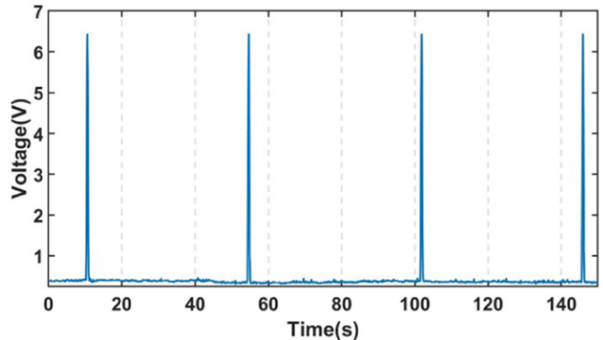
Figure 8. Steady sampling signal for 350 μ m iron particles.